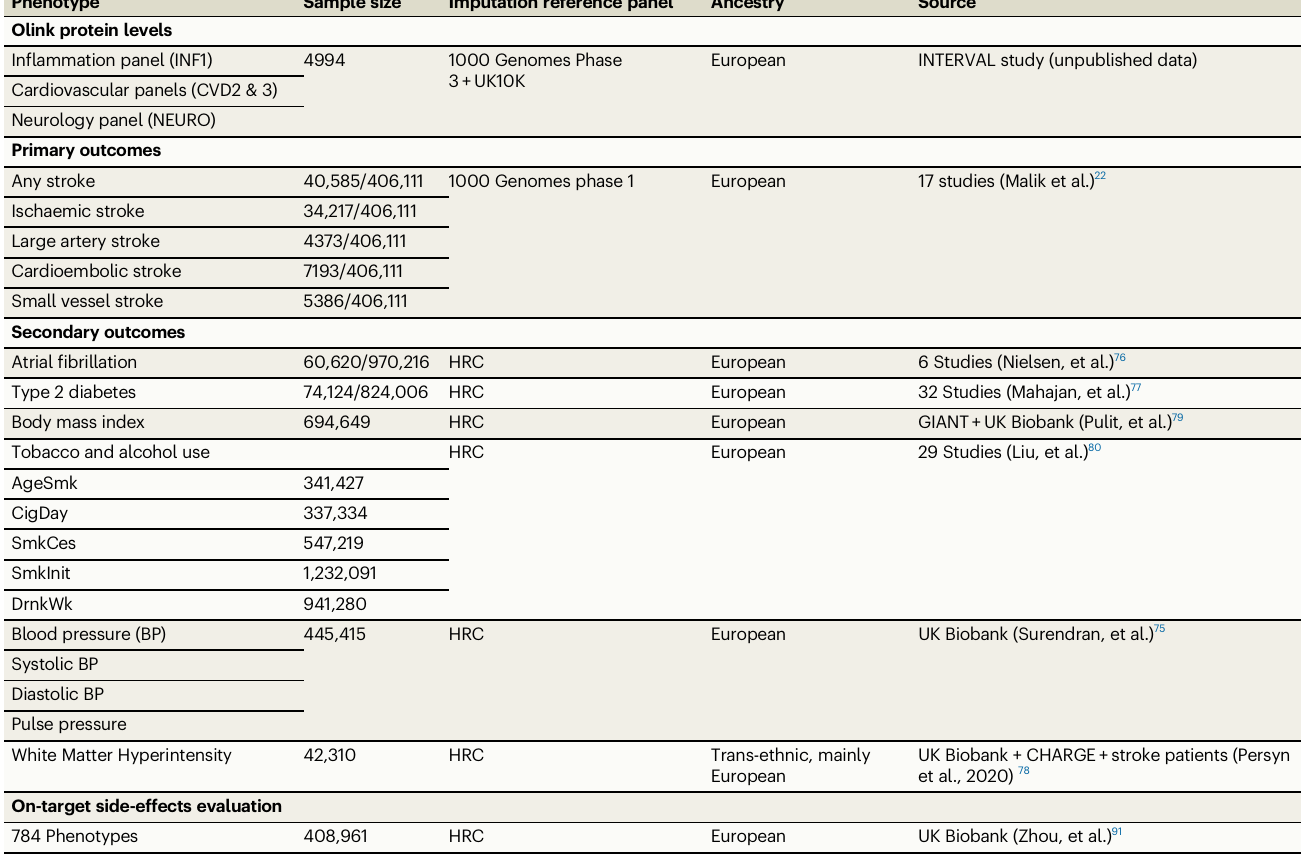
Table 1 | Data sources for the Mendelian Randomisation analysis in the current